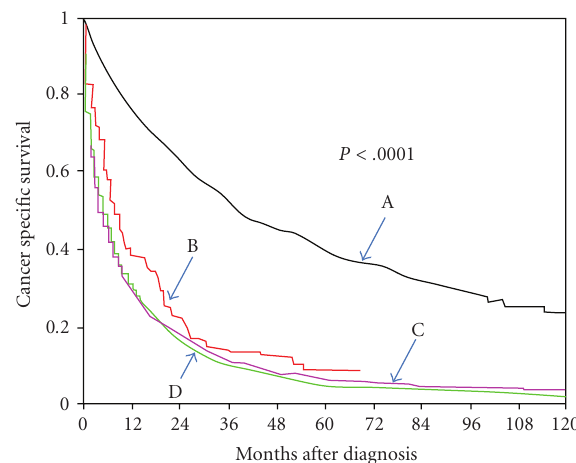
Figure 1: Cancer-specific survival in patients with HCC who refused or underwent cancer-directed surgery. Cancer-specific survival curve: A, CDS; B, CDS refused; C, CDS recommended but not performed; D, noncandidates for